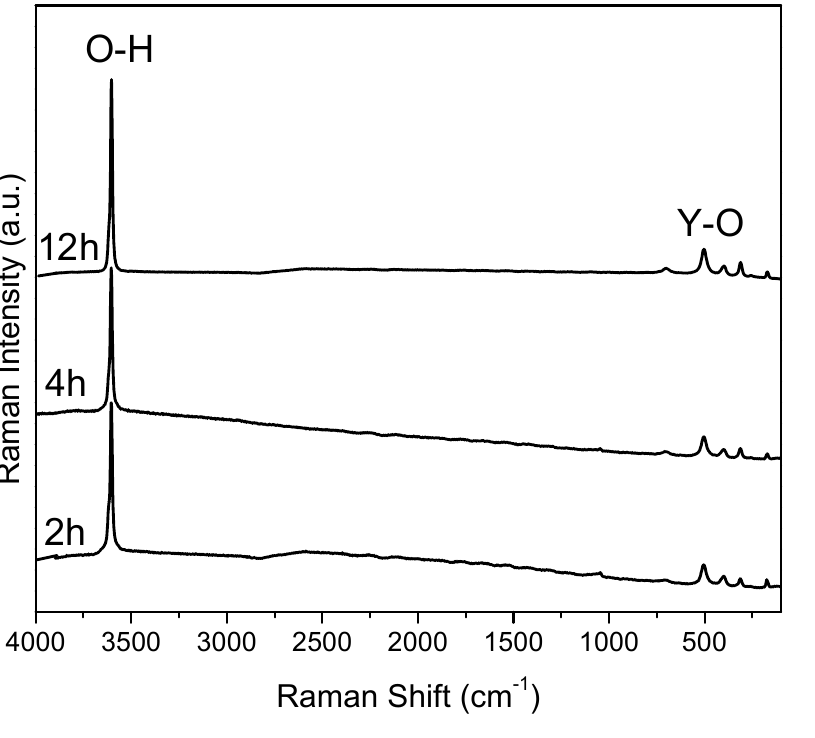
Figure 2 Raman spectra of the samples collected at 2, 4 and 12 hours. Full-size DOI: